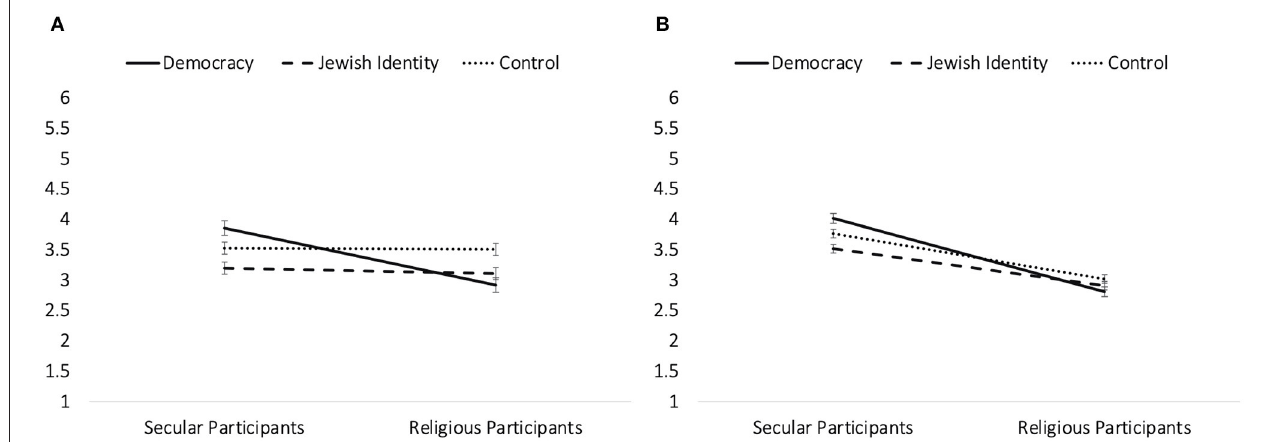
FIGURE 1 | The results of the interaction between the condition and level of religiosity of participants on (A) openness to alternative information and (B) support for negotiations and conciliatory policies in Study 2. Error bars represent